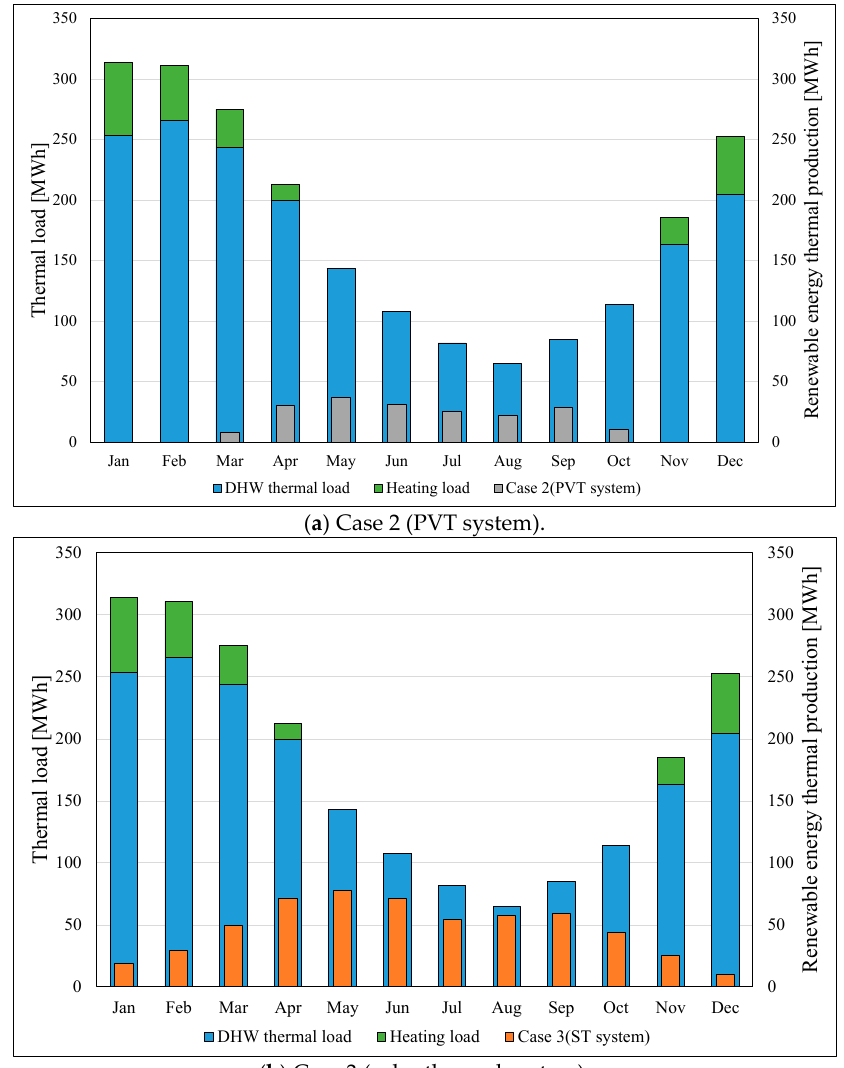
Figure 5. Monthly thermal energy production by solar thermal system.